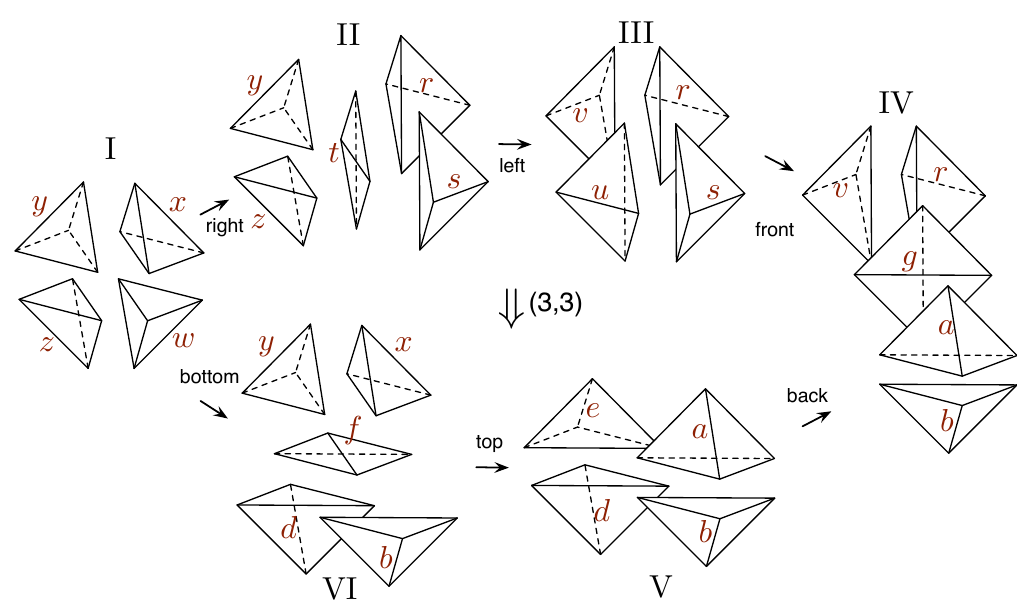
Figure 7 . Six theories of class